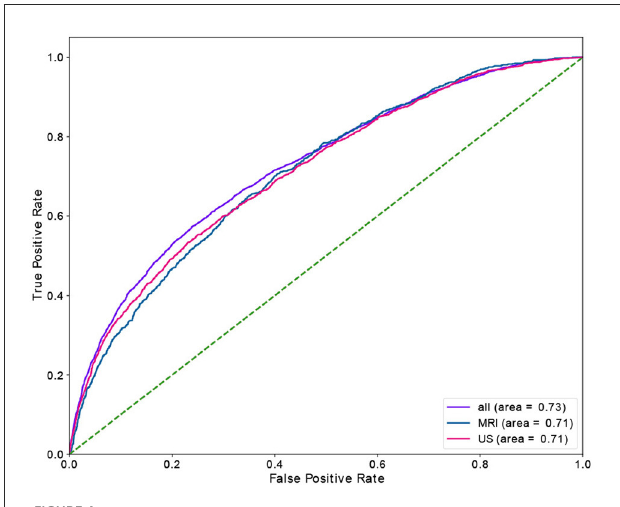
FIGURE4 ROC curve of multivariant RF model for waiting-room-time